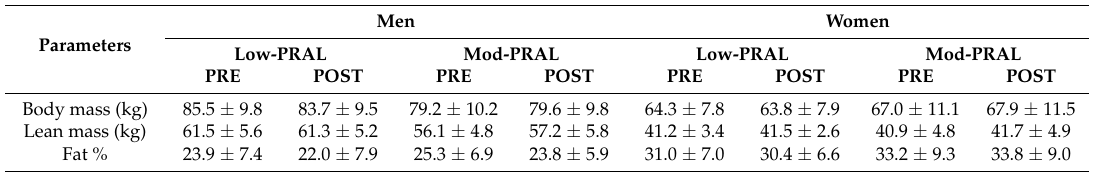
Table 4. Body composition before (PRE), and after (POST) the 12-week diet period in low-PRAL and moderate-PRAL diet